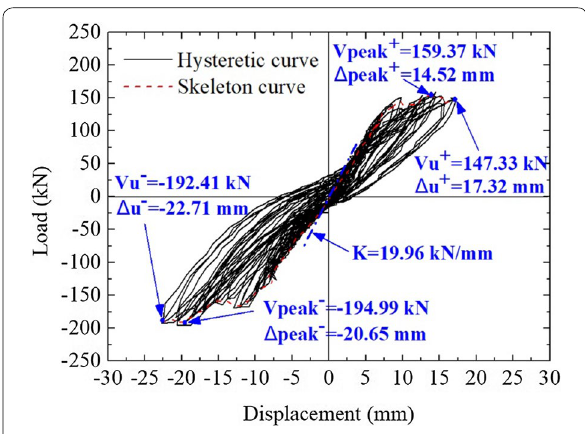
Fig. 9 Stiffness degradation